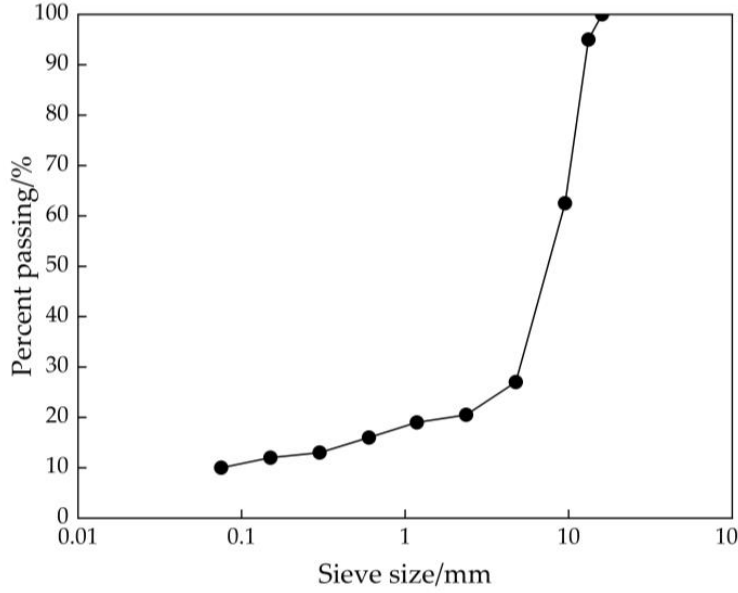
Figure 2. Aggregate gradations of investigated mixtures.